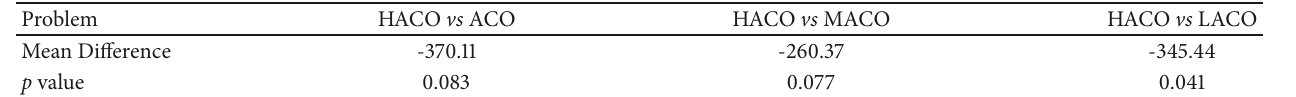
Table 4: Results of paired t -test based on route